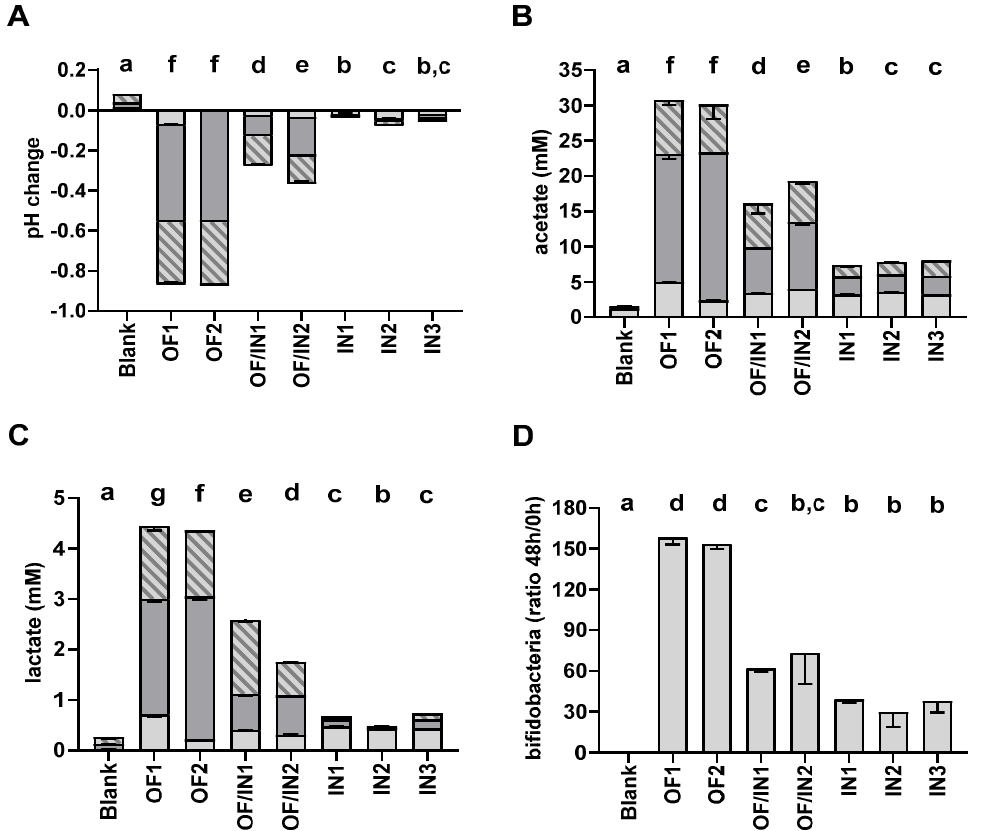
Figure 2. Metabolic activity of BB-12 upon dosing fructans with short (OF1, OF2), intermediate (OF/IN1, OF/IN2) and high degree of polymerization (IN1, IN2 and IN3) versus a blank incubation in monocultures. Bars represents the average changes ( ± SD) in pH ( A ), acetate (( B ); mM) and lactate (( C ); mM) levels between 0 and 6 h (light grey), 6 h and 24 h (dark grey) and 24 h and 48 h (stripes) as well as changes in Bifidobacterium levels (( D ); expressed as the ratio of their absolute abundance as measured via qPCR at the end versus the beginning of the incubation (48 h/0 h)) ( n = 3). Conditions that have no letter in common are statistically significantly different from one another ( p < 0.05). BB-12 = Bifidobacterium animalis subsp. lactis; SD = standard deviation; OF = oligofructose; IN = inulin.